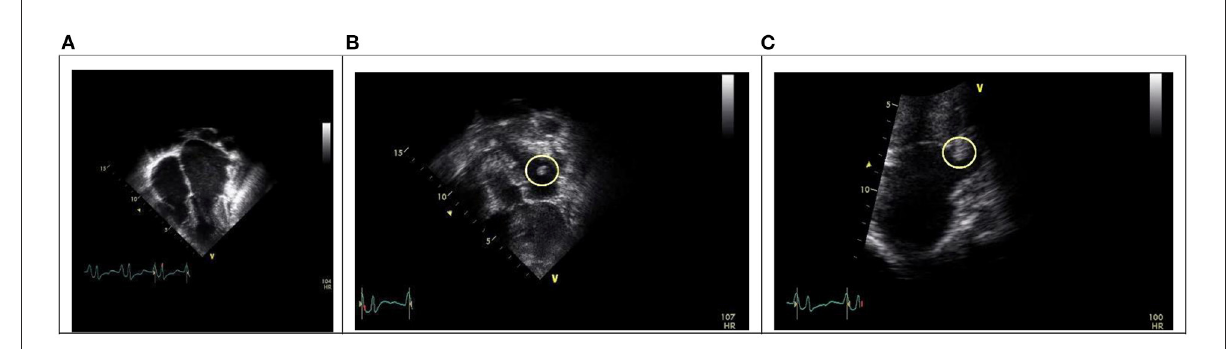
FIGURE3 (A) Apical four chamber view showing bi-atrial dilatation with normal ventricles size. (B) A thrombus mass in the left atrium close to the left atrial appendage (yellow circle). (C) A thrombus mass in the left lower pulmonary